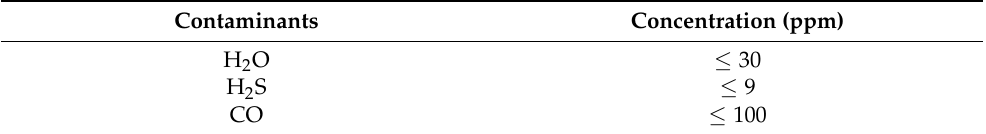
Table 2. Purity requirements for CO 2